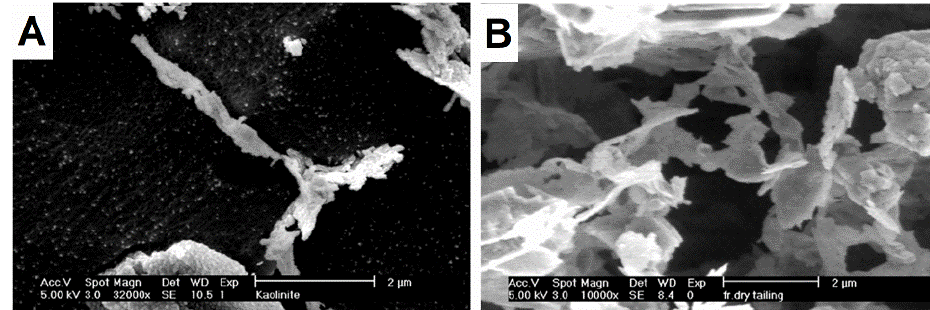
Figure 1. Edge to edge orientation of kaolinite platelets in dilute aqueous: ( A ) kaolin separate platelets in the freeze ‐ fracture micrograph and ( B ) EE oriented kaolinite platelets in freeze ‐ drying coal ‐ associated kaolin (Reproduced from Ż bik et al. (2003) [62] , Copyright © 2021, with permission from the publisher, License No. 5217490592881).